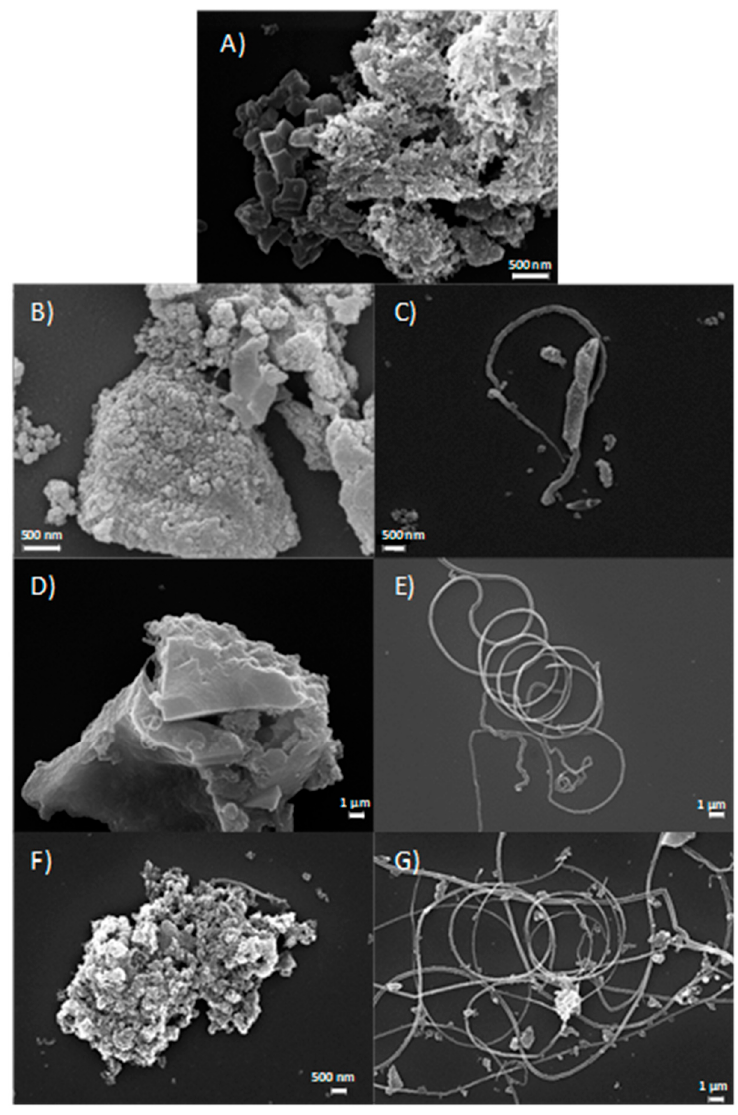
Figure 5. SEM images: ( A ) S_GA; ( B , C ): S_GA_Cu; ( D , E ): S_GA_Fe; ( F , G ): S_GA_FeCu.